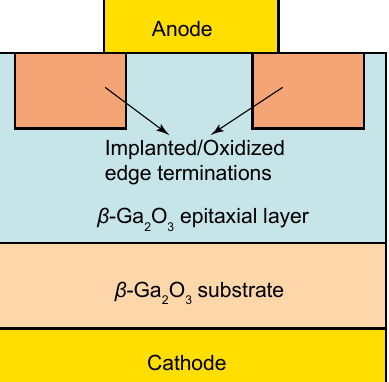
Figure 6. Device diagram of β‐ Ga 2 O 3 SBD with edge terminations.